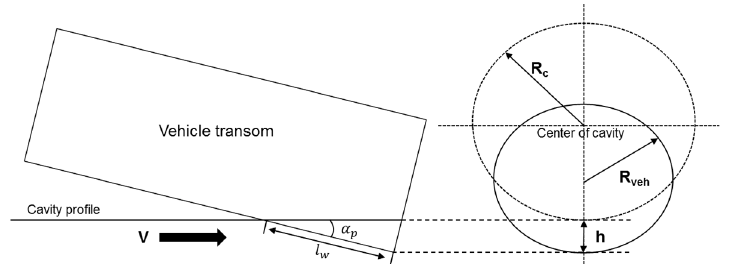
Figure 5. Flow diagram for the vehicle planing in the cavity.